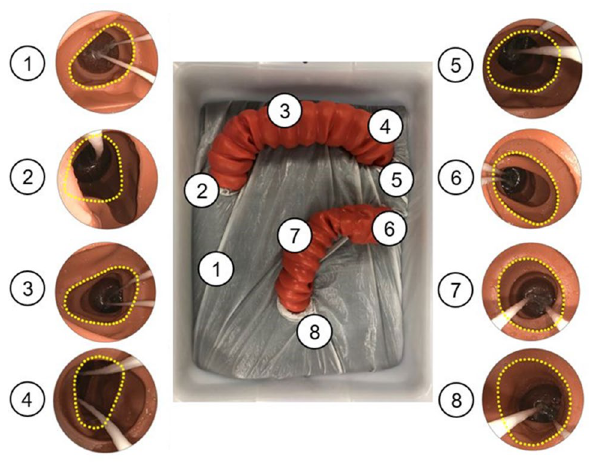
Figure 2. Ex vivo study setting to investigate the reach of Ig/ IgE. The synthetic colorectum was positioned within an established 3D model and fixed by clamps at 4 points. Endoscopic view of Ig/IgE was demonstrated at each position: the ascending colon (site 1), proximal to the hepatic flexure (2), the transverse colon (3), proximal to the splenic flexure (4), the descending colon (5), proximal to the sigmoid-descending colon (6), the sigmoid colon (7), and the rectum (8).